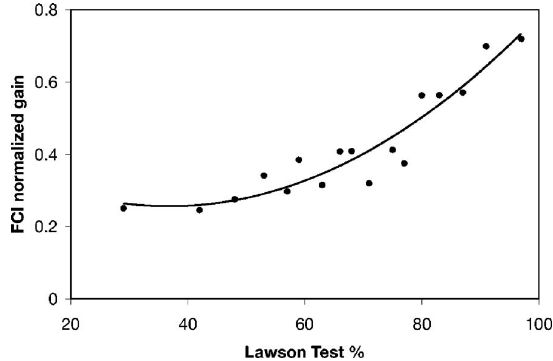
FIG. 4. Plot of normalized gains versus Lawson Test scores for 297 LMU and ELHS students, with individual student data aver- aged within